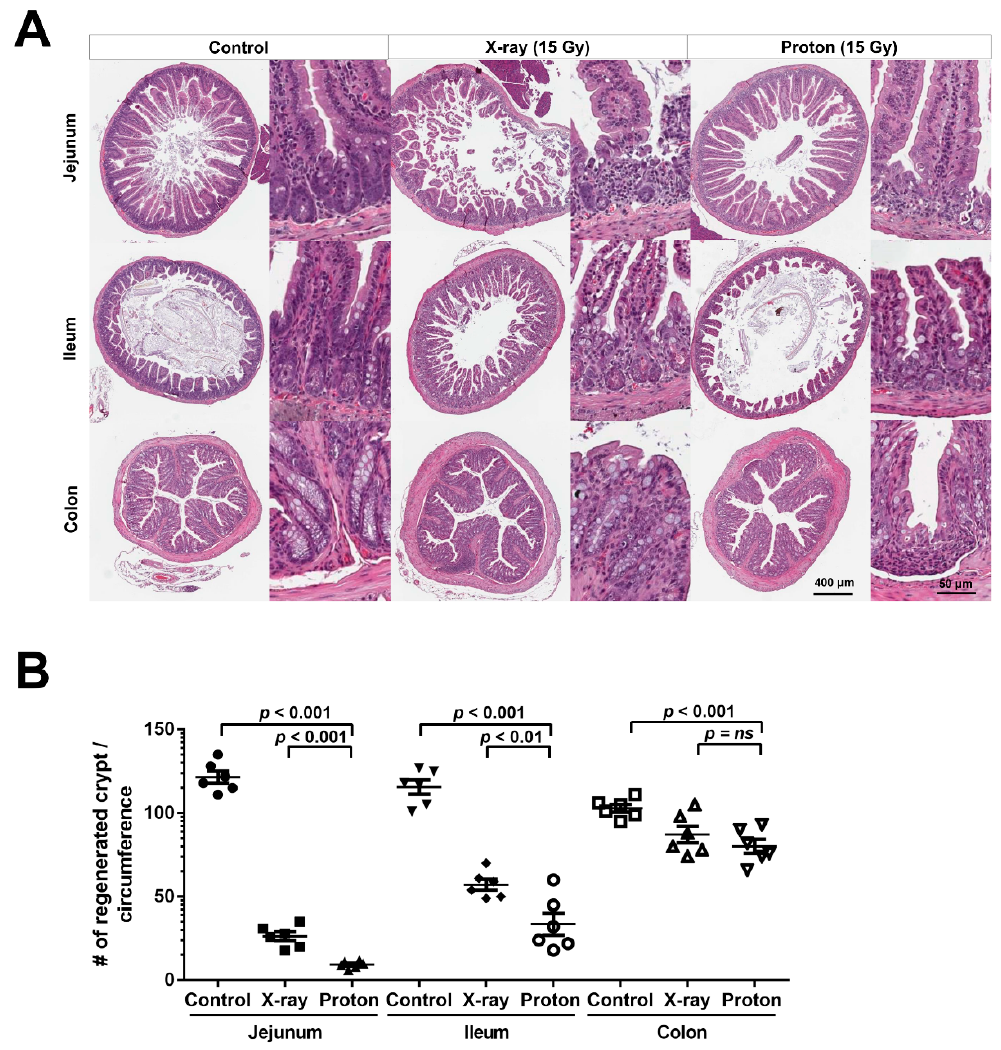
Figure 2. Proton irradiation is more e ff ective in suppressing crypt survival in the mouse small intestine than X-ray irradiation. ( A ) A remarkable decrease in the number of crypts in the small intestine and the colon irradiated with 15 Gy of X-rays or protons compared with unirradiated control tissues: The tissue samples were collected at 3.5 days after irradiation. The representative images of the H&E-stained sections of the jejunum, ileum, and colon are presented herein. ( B ) A quantitation of the crypt numbers per circumference showed that proton irradiation decreased the number of crypts more e ff ectively than X-ray irradiation in both the jejunum and the ileum but not in the colon.